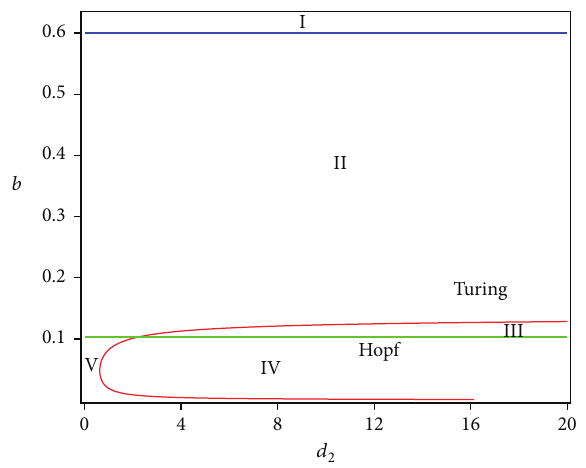
Figure 5: Bifurcation diagram of system (2) for 𝑠 = 0 . 15, 𝑎 = 4, = 0 . 1. The green line is the Hopf bifurcation line, 𝑘 = 0 . 2, and 𝑑 1 and the red curve is the Turing bifurcation